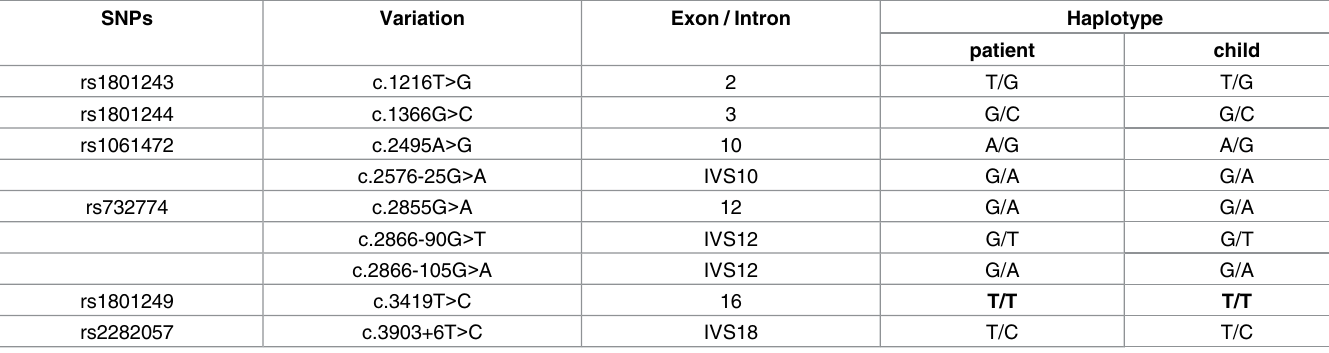
Table 1. Intragenic SNPs used for the haplotype analysis and the haplotype of patient and child.